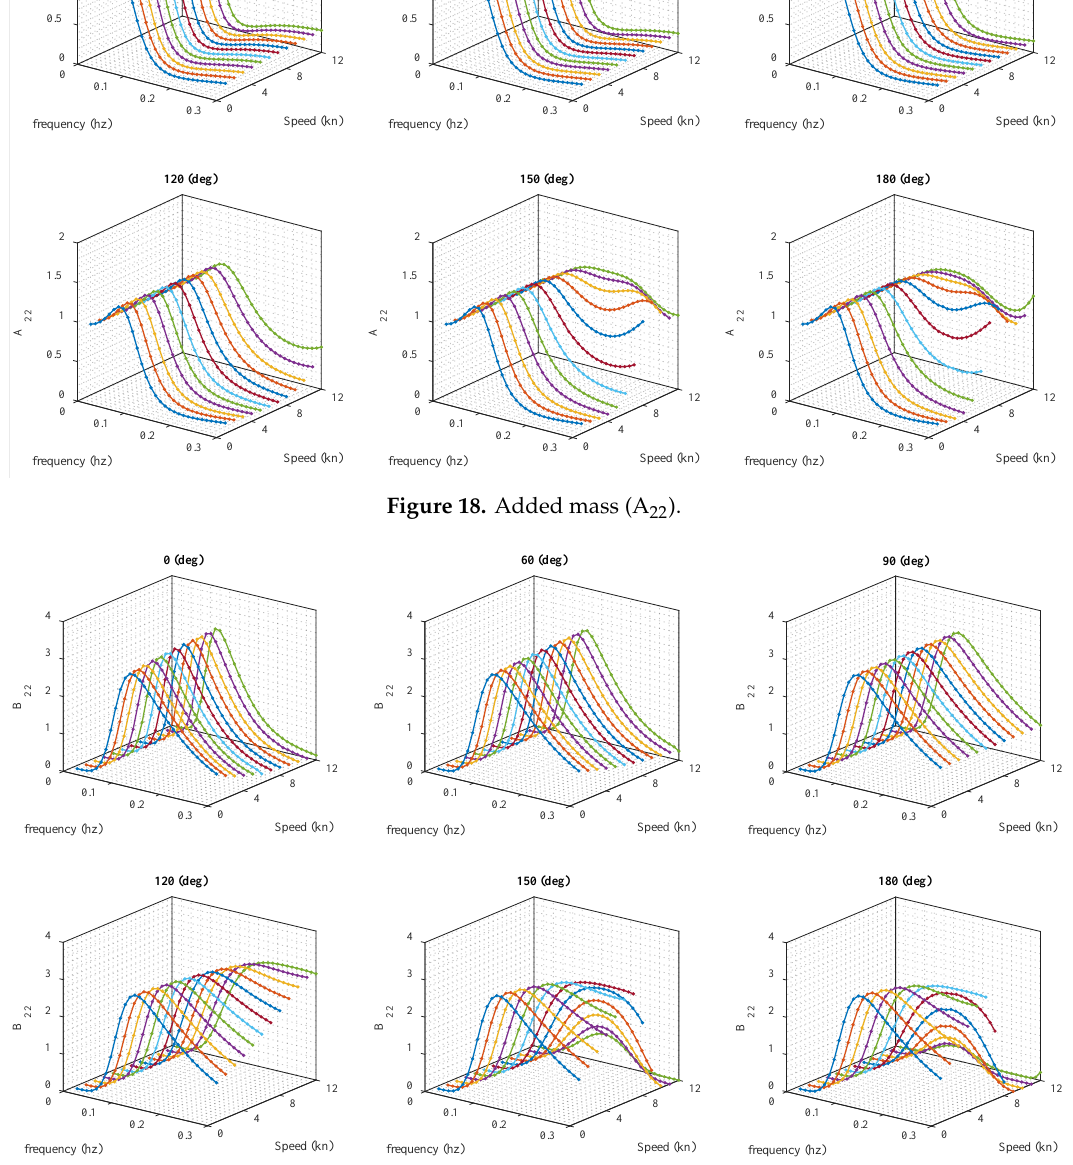
Figure 19. Damping coefficient (B 22 ).